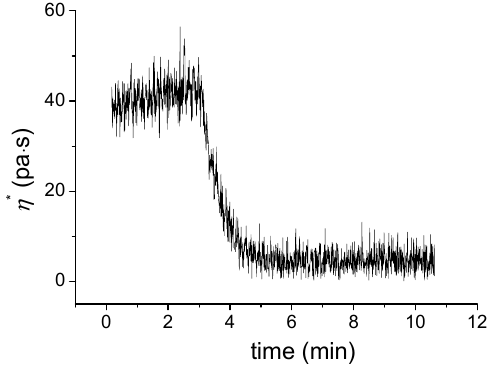
Figure 6. Plot of viscosity against the temperature of D-Azo-D 230 in water (5.0 wt%). The data were obtained at a constant frequency of 5 rad/s and a strain of 1.0%.